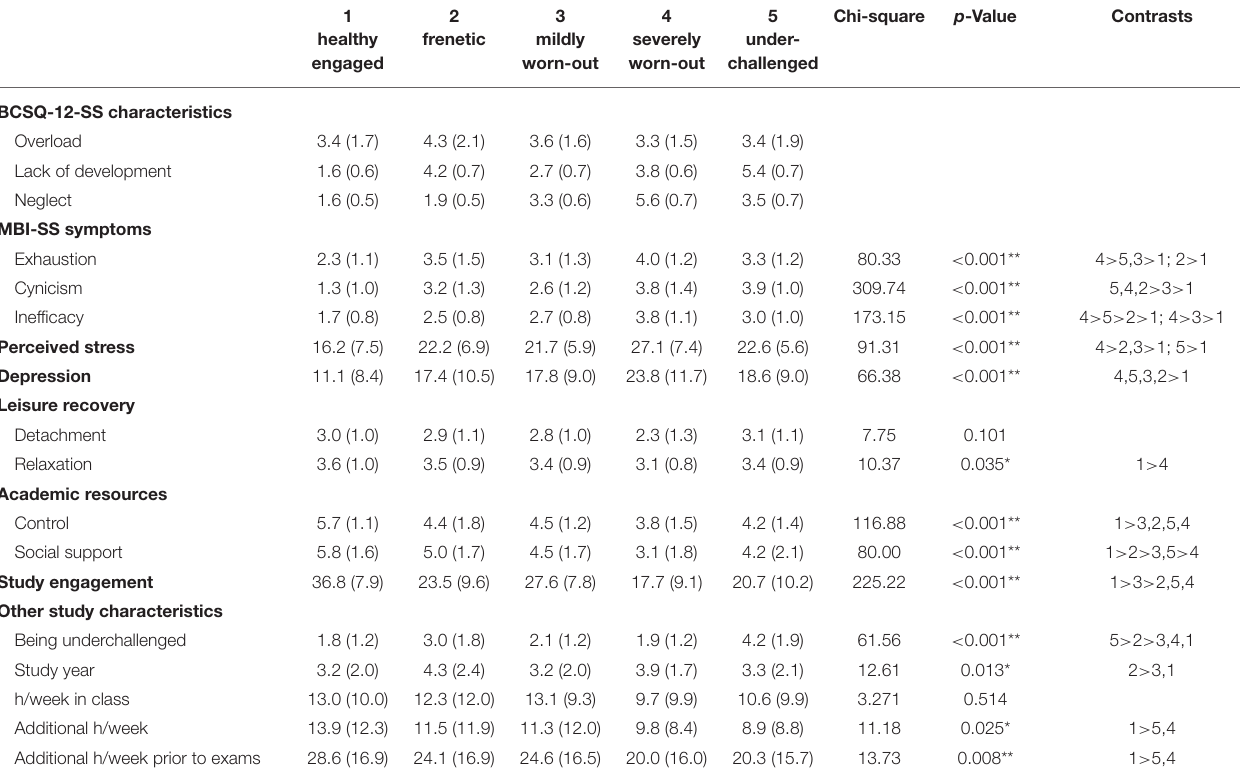
1 2 3 4 5 Chi-square p -Value Contrasts healthy frenetic mildly severely under- engaged worn-out worn-out challenged